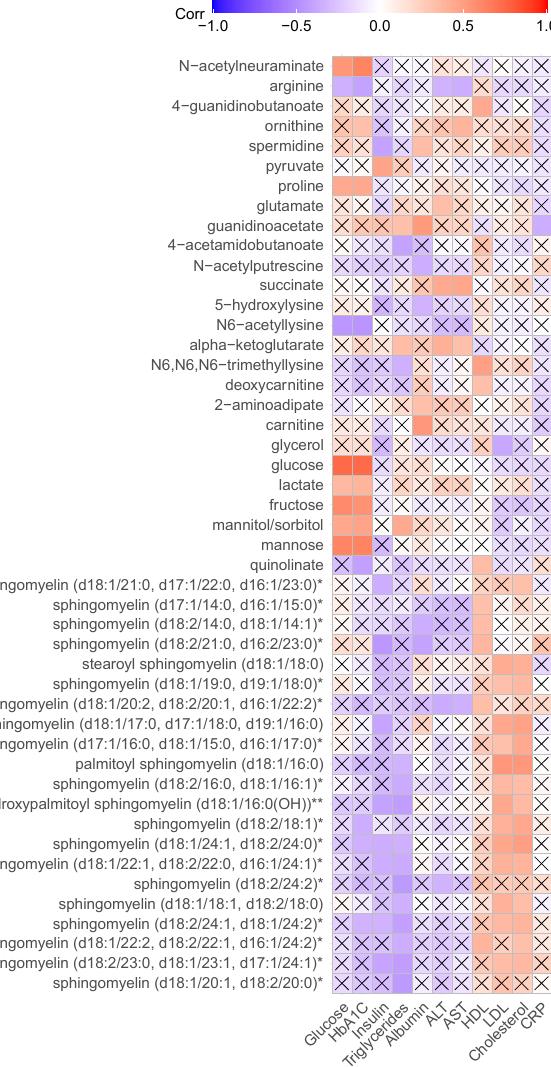
Figure 5. Heatmap of correlation of differentially expressed metabolites in OBO and OBM. Each row represents a metabolite, and a column represents a clinical parameter. A cross indicates that correlation is not significant ( p < 0.05).